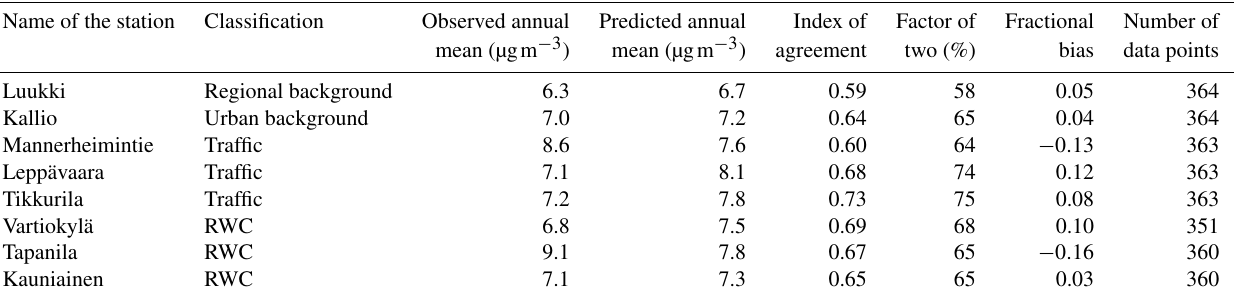
Table C2. Selected statistical parameters for the agreement of predictions and measurements for the daily concentrations of PM 2 . 5 in the Helsinki area in 2013. RWC stands for residential wood